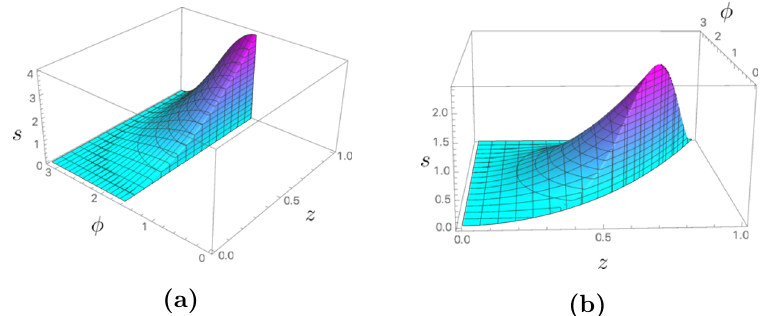
Figure 3. IR unsafe observables that our code (a) can and (b) can’t